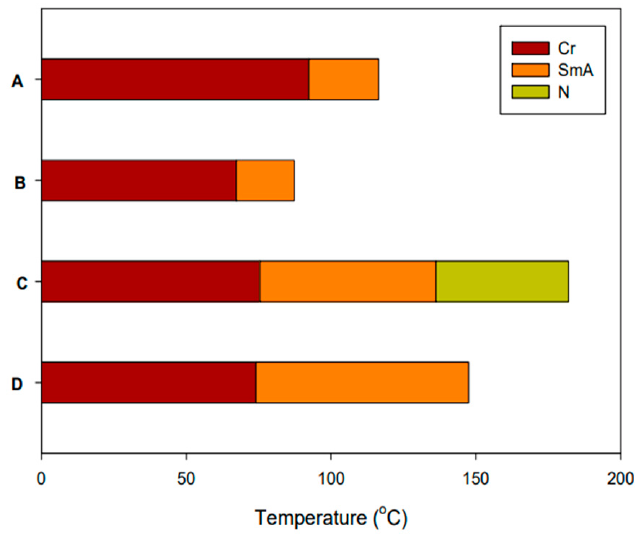
Figure 9. DSC transition of compound 7(a – d) . Reprinted/adapted with permission from Ref. [29]; published by MDPI AG, 2019.